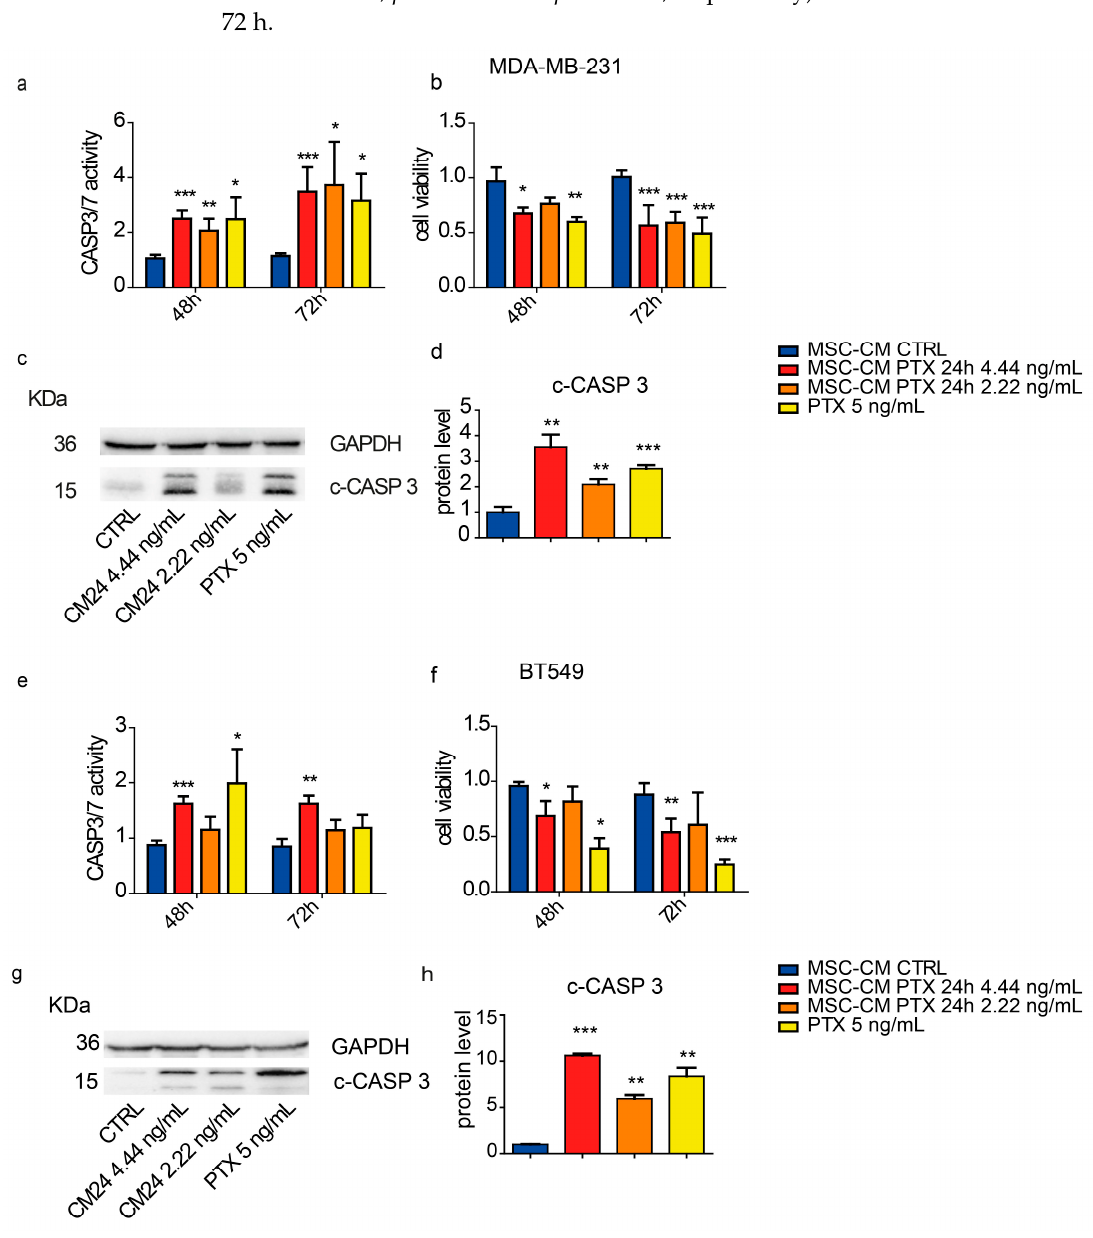
Figure 5. Effect of MSC-CM PTX on Caspase 3/7 activity and cell viability of TNBC cells. Caspase 3/7 activity ( a , e ) and cell viability ( b , f ) of TNBC cells were measured after treatment with 1:50 (4.44 ng/mL) and 1:100 (2.22 ng/mL) MSC-CM PTX 24 h dilution or with free PTX. MDA-MB-231 and BT549 were seeded 5000 cells/well in 96-well plates and exposed to two dilutions (1:50 and 1:100) of MSC-CM PTX 24 h for 48 and 72 h. Caspase-3/7 activity was measured using the luminescent Caspase-Glo ® 3/7 Assay, and the results were normalized vs. MSC-CM CTRL, expressed as caspase activity fold changes over CTRL ( a , e ). On the right, the viability assay analysis is shown ( b – f ). All data points represent the means of the assays performed in triplicate ± SDs (n = 3). Representative images of Western blotting ( c – g ) and quantification ( d – h ) of three independent experiments show- ing cleaved caspase 3 protein expression. Error bars describe SDs, and unpaired t -tests determined p -values: * p < 0.05, ** p < 0.01, *** p < 0.001.